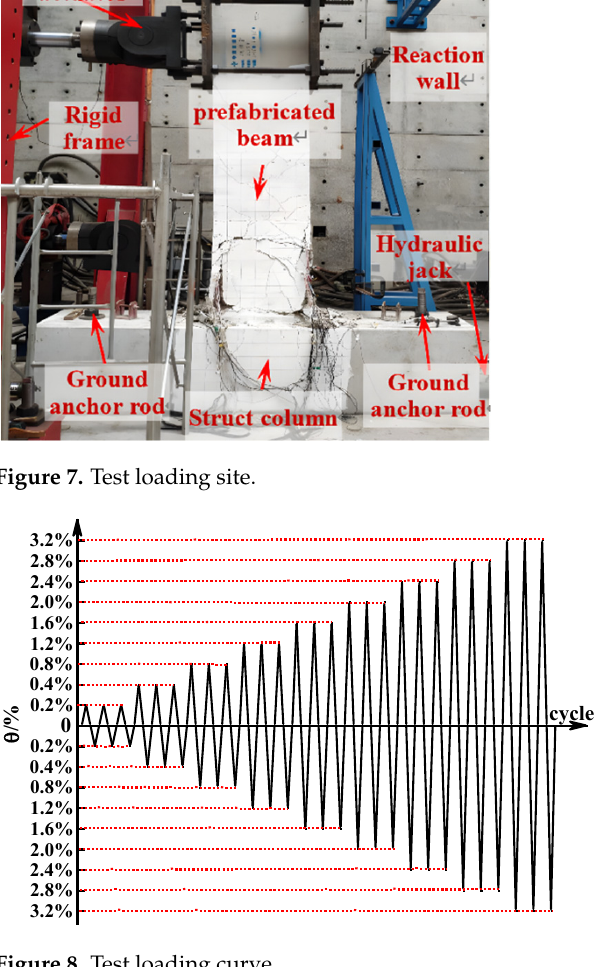
Figure 8. Test loading curve.